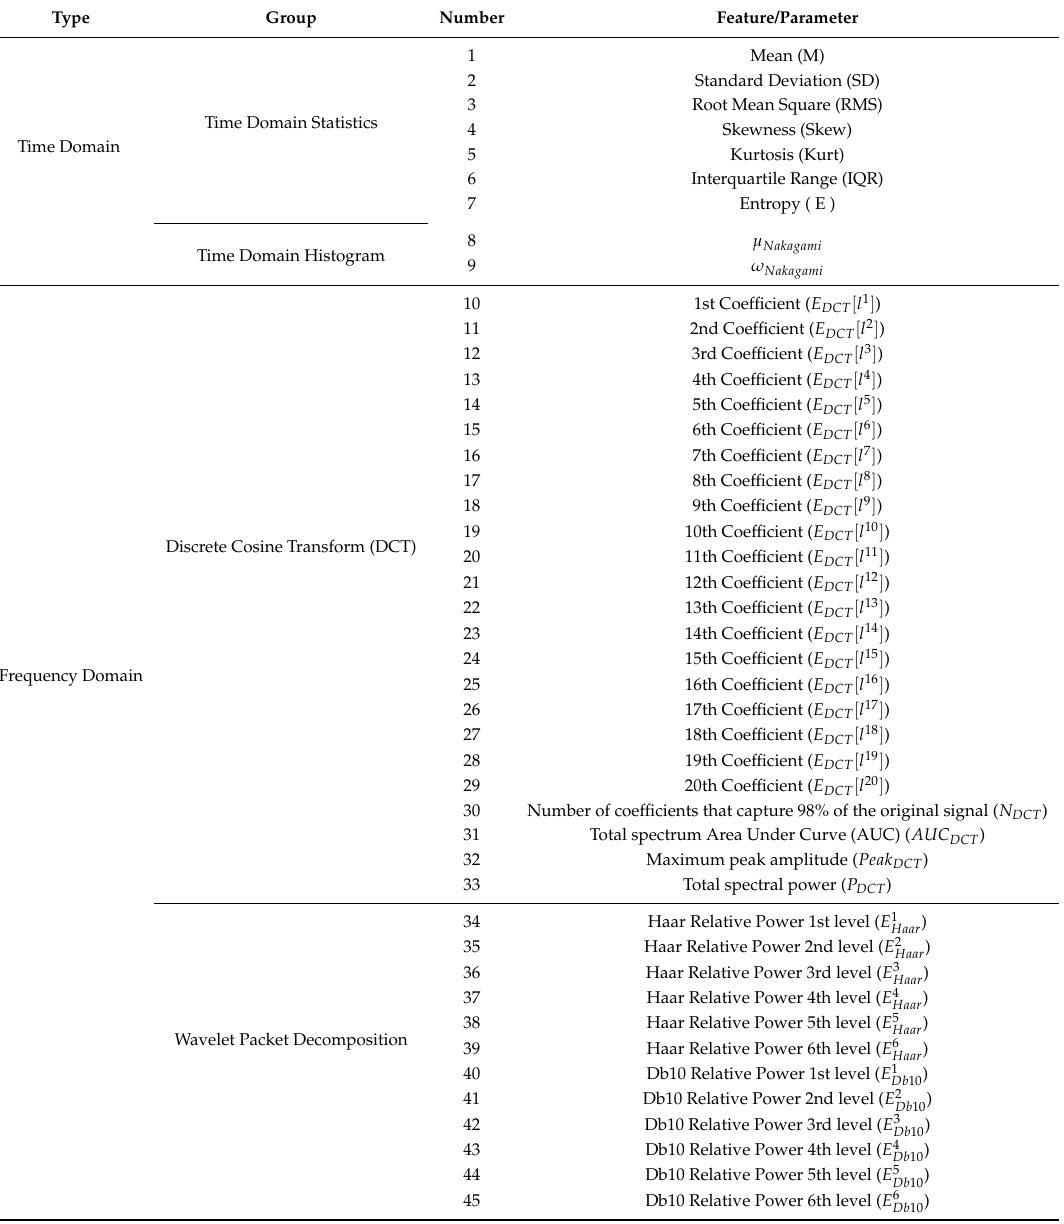
Table 3. Table summarizing the back-scattered signal features/parameters set evaluated in this